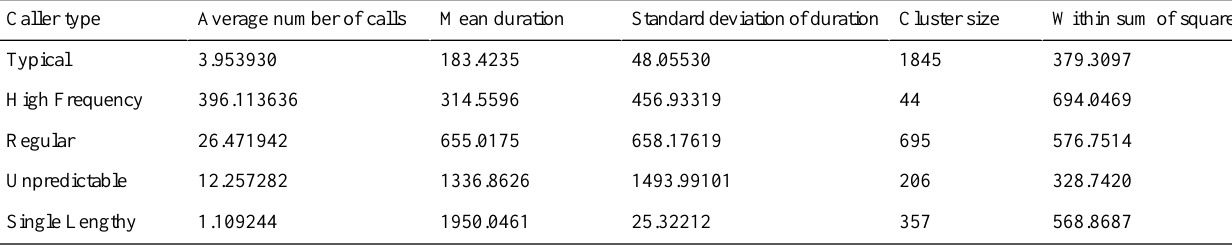
Table 4. Cluster centroids of callers within the Active COVID-19